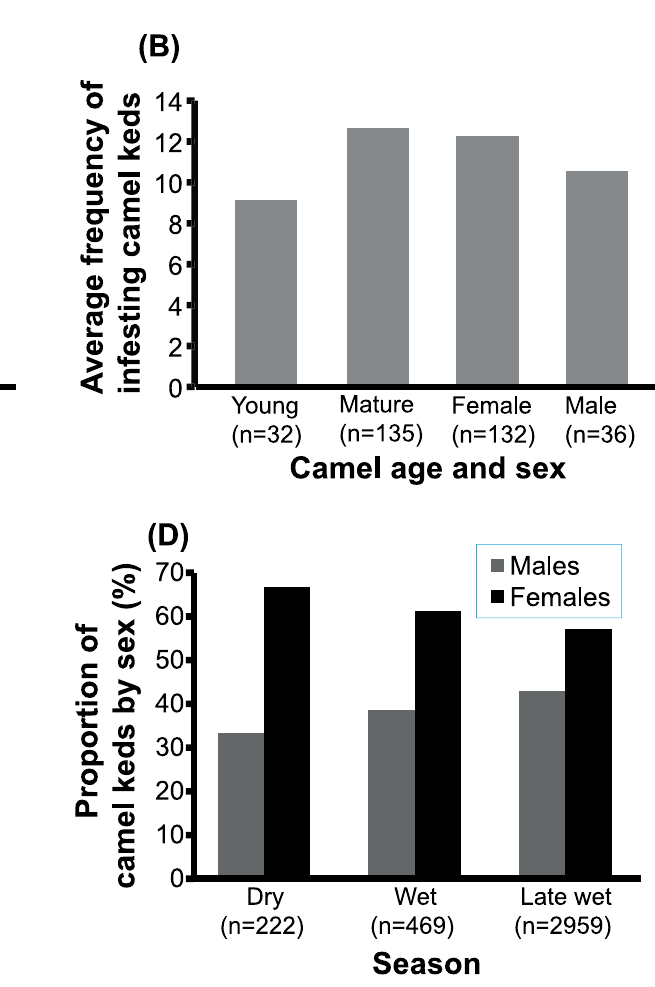
Fig 3. Baseline survey data of livestock keds in Laisamis, northern Kenya. (A) Ked infestation in domestic animals. Hippobosca camelina , that spends its adult life attached on the host, was predominantly found on camels, indicating its camel-specific preference. However, in rare instances, about 1 to 3 H . camelina flies were collected from sheep and goat herds that were co-herded with camels (but not found on other livestock species studied here). Highest mean ked infestation was recorded on camels, followed by dogs, and then donkeys. (B) The influence of host age and sex on the preference of keds to infest camels. Mature camels had higher average numbers of keds as compared to the young camels. Camel sex did not influence ked infestation ( p = 0.5508). (C) Seasonal variations of ked infestations on camels. The highest numbers of keds were recorded on camels during dry season followed by late wet season. The lowest ked numbers were recorded on the camels during the wet season. (D)Proportions of male and female keds on camels. The proportion of female keds was higher than the male flies sampled across the three